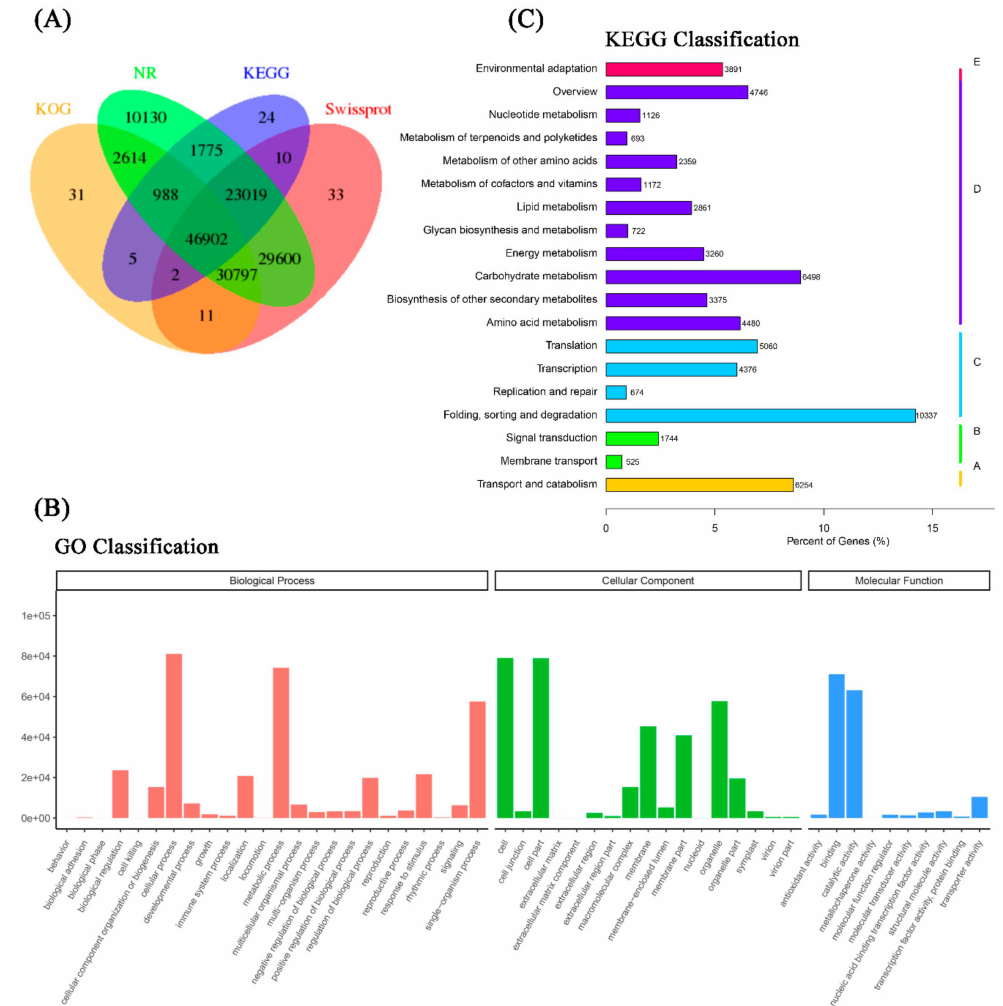
Figure 2. Functional annotation of the full-length reference transcriptome. ( A ) Venn diagram of all isoforms from the reference transcriptome hits of KOG, non-redundant proteins (NR), Kyoto Encyclopedia of Genes and Genomes (KEGG), and SwissProt databases. ( B ) Gene ontology classification of all identified isoforms from the reference transcriptome. ( C ) KEGG classification of all identified isoforms from the reference